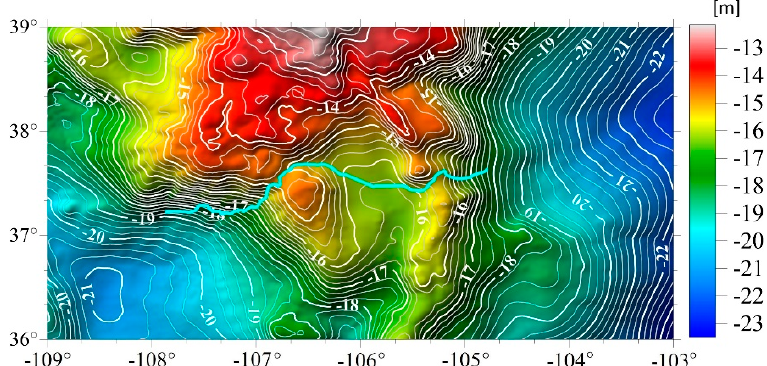
Figure 5. Map of the quasigeoid model determined using the GGI method. The light blue line is the location of the GSVS17 profile.